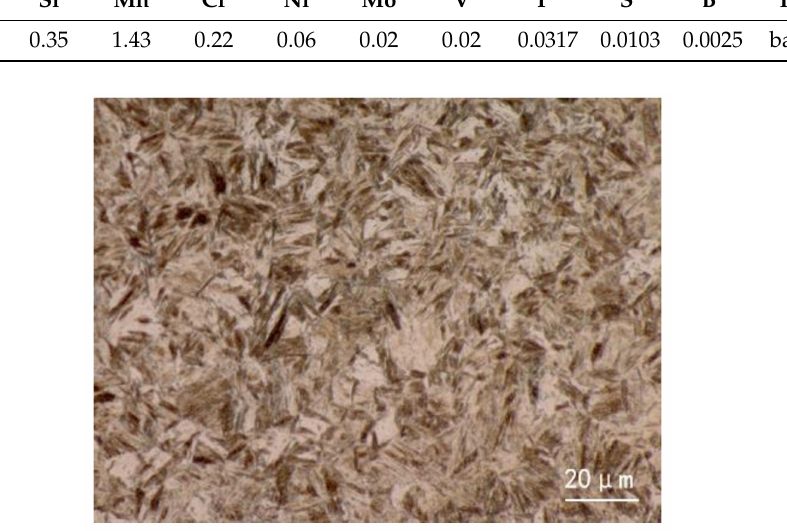
Figure 1. Optical microstructure of the hot-stamped hardened